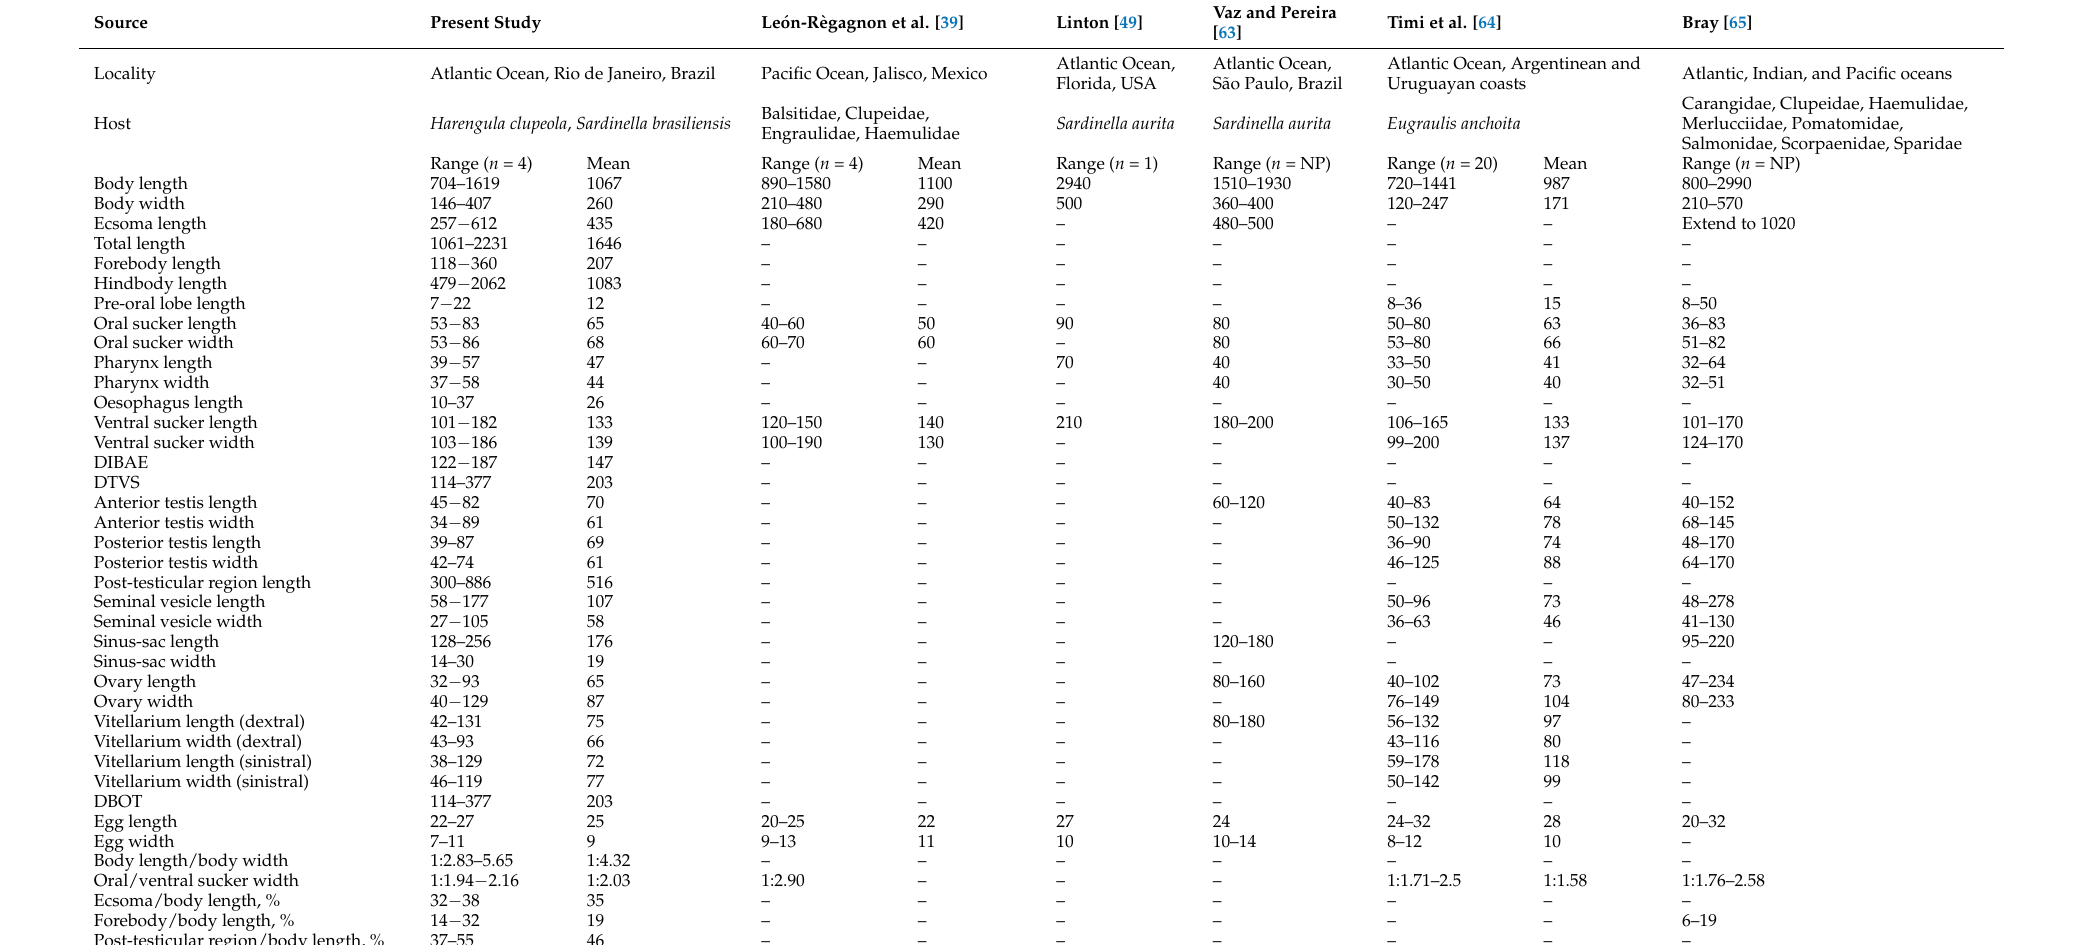
Table 3. Comparative metrical data of Parahemiurus merus (Linton,